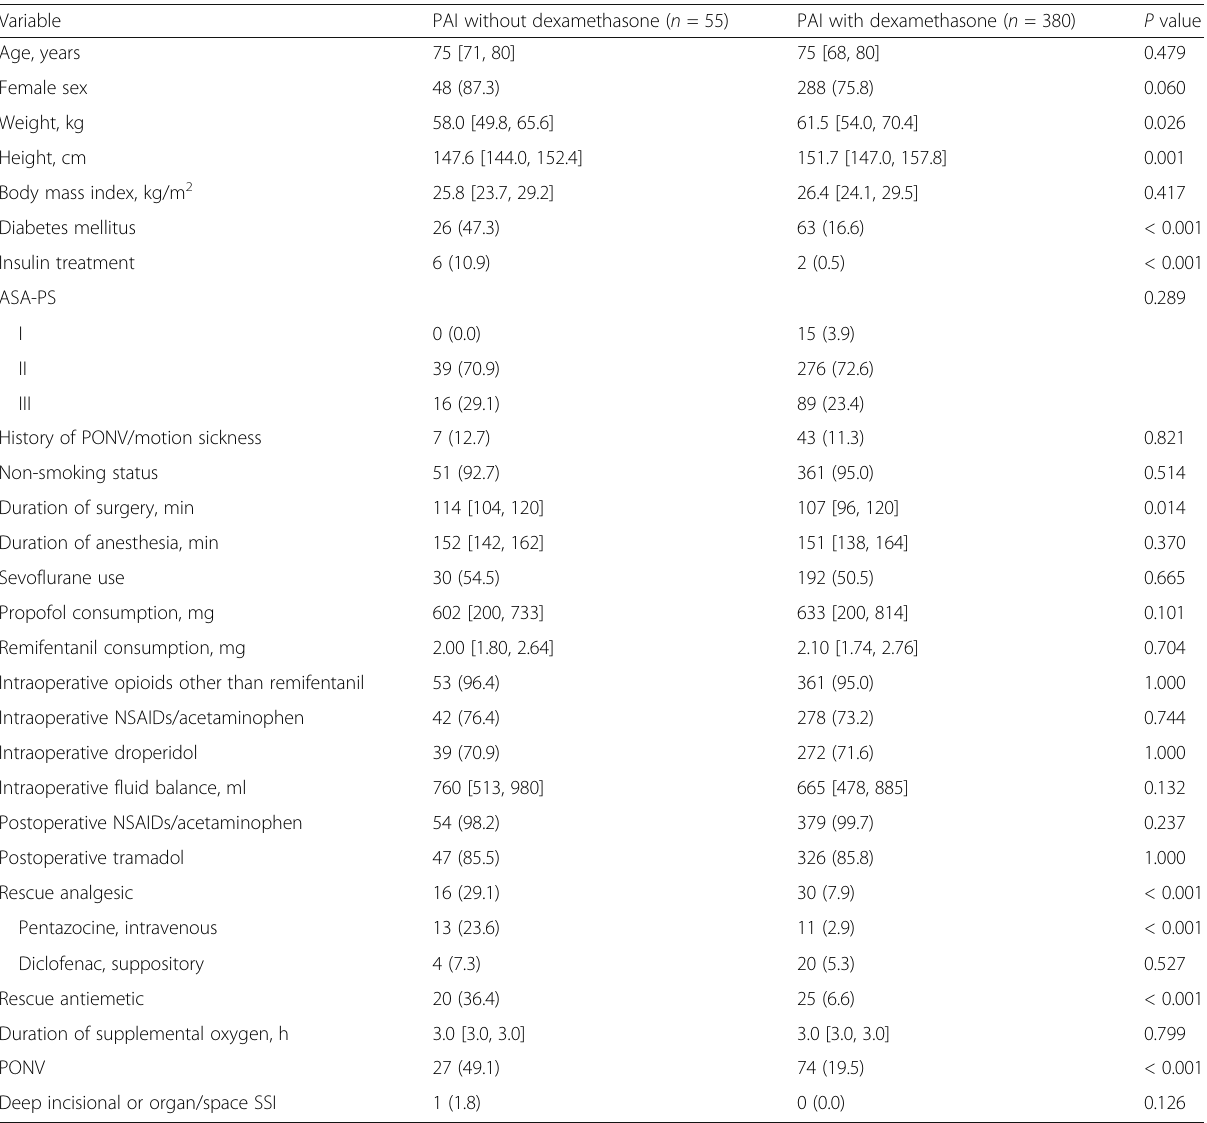
Table 3 Patient characteristics according to the intervention with the addition of dexamethasone to periarticular anesthetic